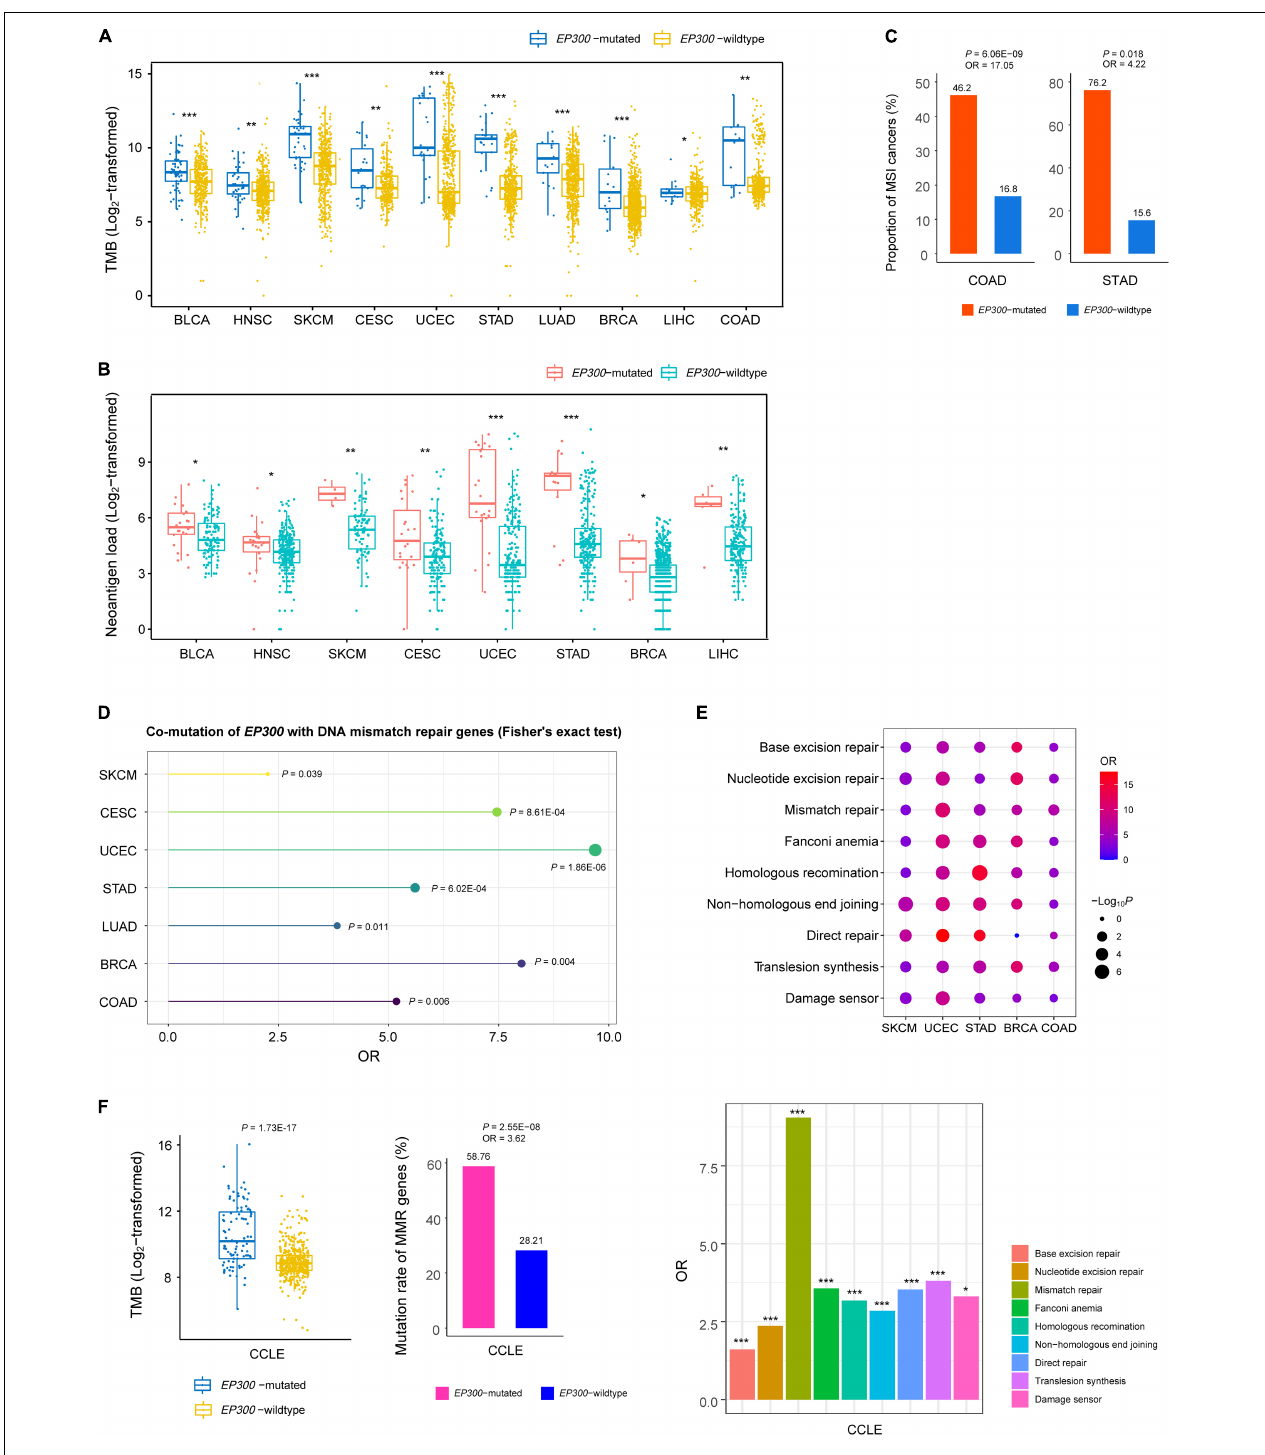
FIGURE 1 | Associations between E1A binding protein p300 ( EP300 ) mutations and genome instability. Comparisons of tumor mutation burden (TMB) (A) , neoantigens (B) , and proportions of microsatellite instability (MSI) cancers (C) between EP300 -mutated and EP300 -wild-type cancers. Co-mutation between EP300 and seven DNA mismatch repair genes ( MLH1 , MLH3 , MSH2 , MSH3 , MSH6 , PMS1 , and PMS2 ) (D) and DNA damage repair (DDR) pathway genes (E) . (F) Comparisons of TMB and mutation rates of DNA mismatch repair genes between EP300 -mutated and EP300 -wild-type cancer cell lines and comparisons of mutation rates between pathway-gene-mutated (PGM) and pathway-gene-wild-type (PGW) groups for each of the nine DDR pathways (Knijnenburg et al., 2018). The one-tailed Mann–Whitney U test p -values are shown in (A,B) . The p -values of Fisher’s exact test and odds ratio (OR) are shown in (C–F) . * P < 0.05, ** P < 0.01, *** P <